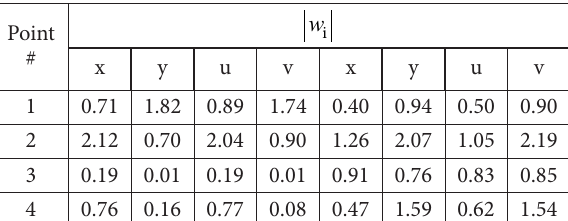
Table 6. The absolute value of the test statistic w i for each of the measurements with gross error in the (u, v) coordinate system Point